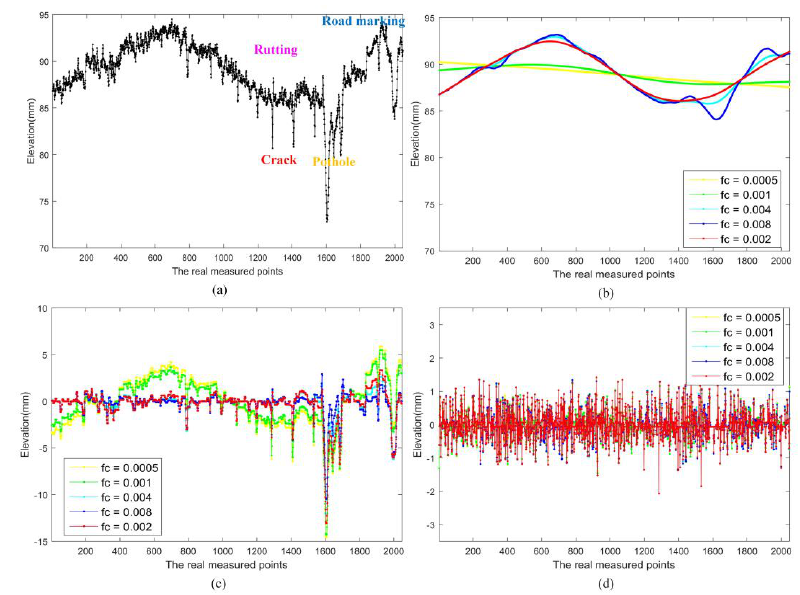
Figure 8. Pavement profile Example 1 and corresponding decomposition with different fc and fixed λ, ( a ) profile data, ( b ) low frequency component with different fc , ( c ) sparse component with different fc , and ( d ) vibration component with different fc .